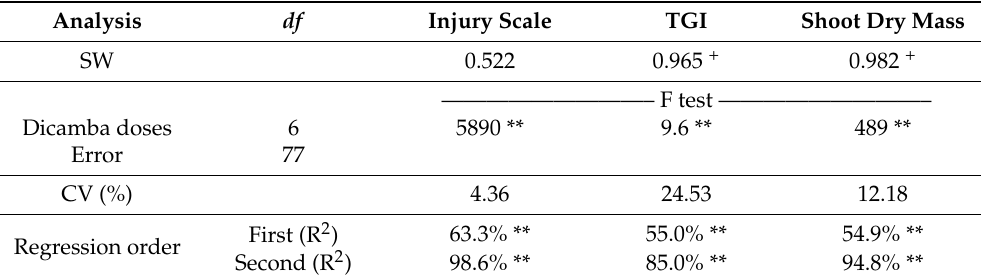
Table 1. Statistic of the normality of residues, analysis of variance (F-test statistic), and regressions of the variables evaluated for soybean treated with dicamba